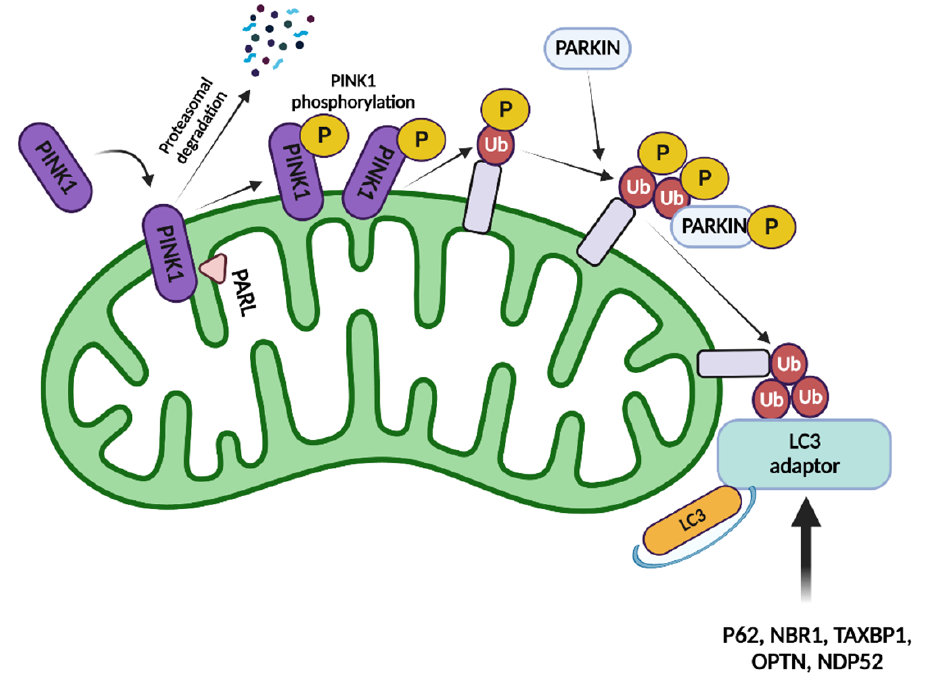
Figure 2. LC3 adaptor recognizes ubiquitinated mitochondrial proteins and induces mitophagy via ubiquitin (Ub)-dependent mechanisms.